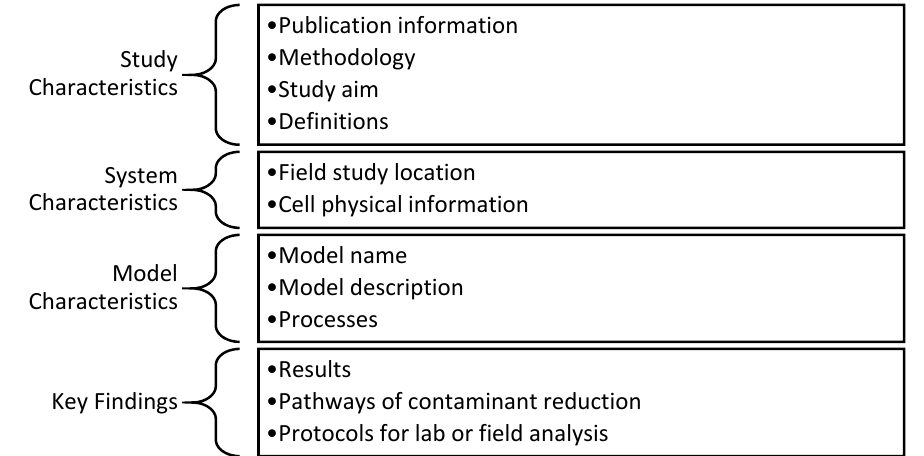
Figure 2. Examples of data extracted under the study, system and model characteristics and key findings categories.